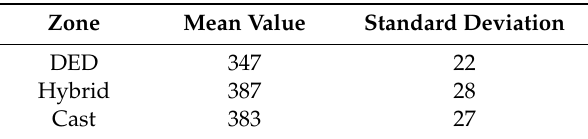
Table 6. Microhardness HV-30 of TNM-B1 samples.